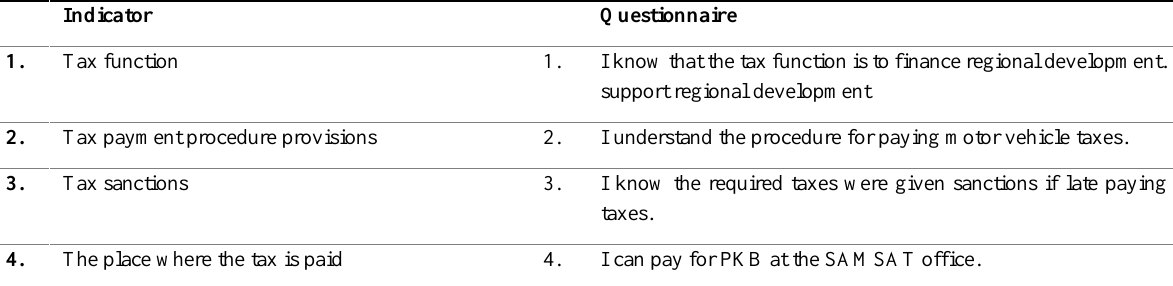
Table 4: Tax Knowledge Variable Indicators